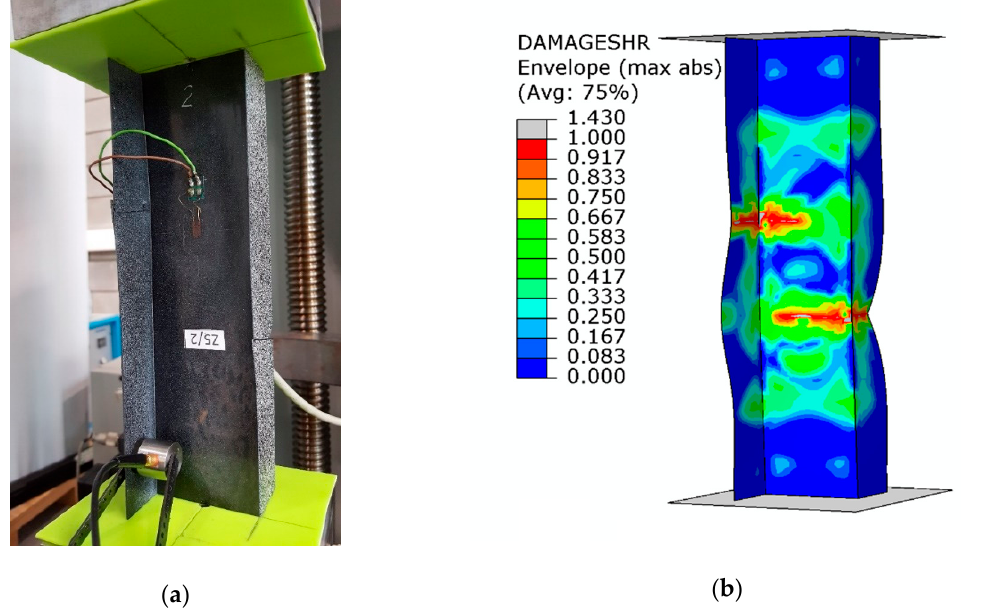
Figure 8. Buckling mode of the structure under axial compression: ( a ) experimental; ( b ) numerical.